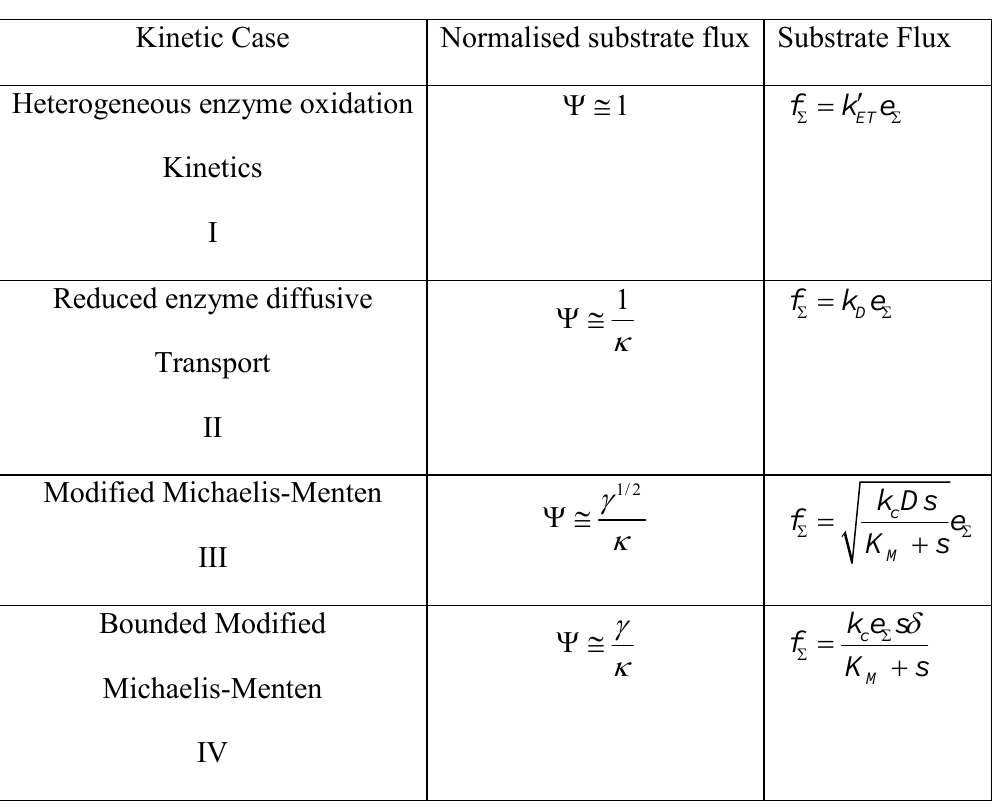
Table 2. Summary of pertinent rate limiting expressions for direct electro-enzyme